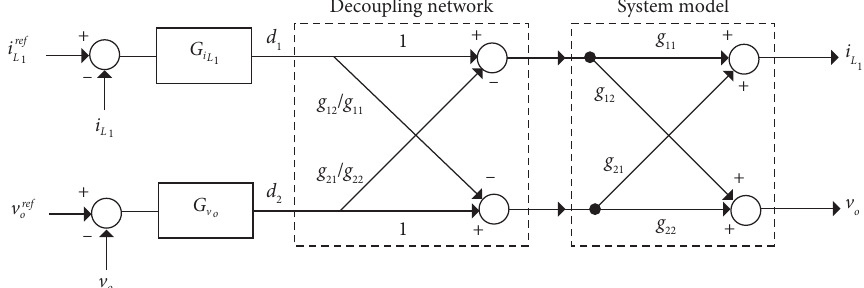
Figure 1: Decoupling control method